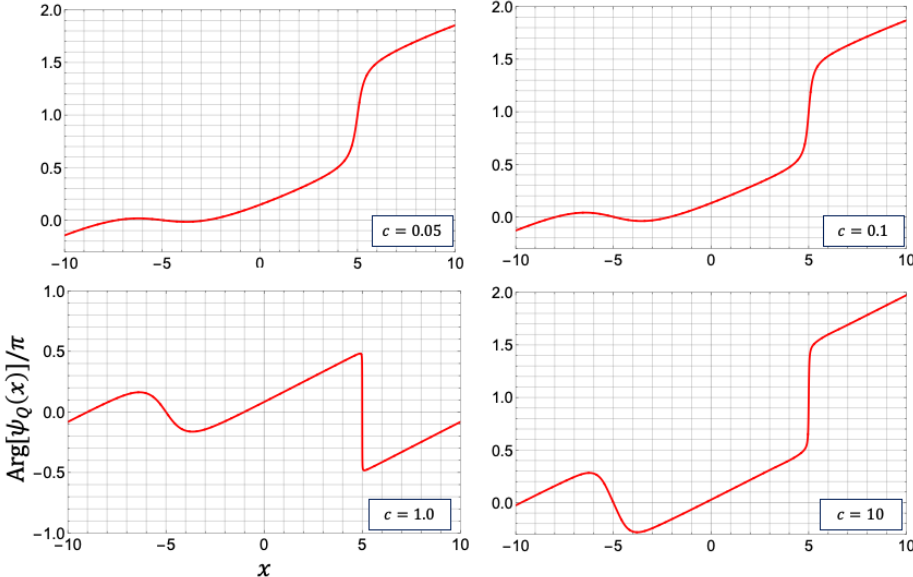
Figure 14. Phase profiles arg [ ψ g ( x )] / π for N = L = 20, and c = 0.05, 0.1, 1.0, and 10. The pairs of the parameters of the Gaussian function are the same as Figure